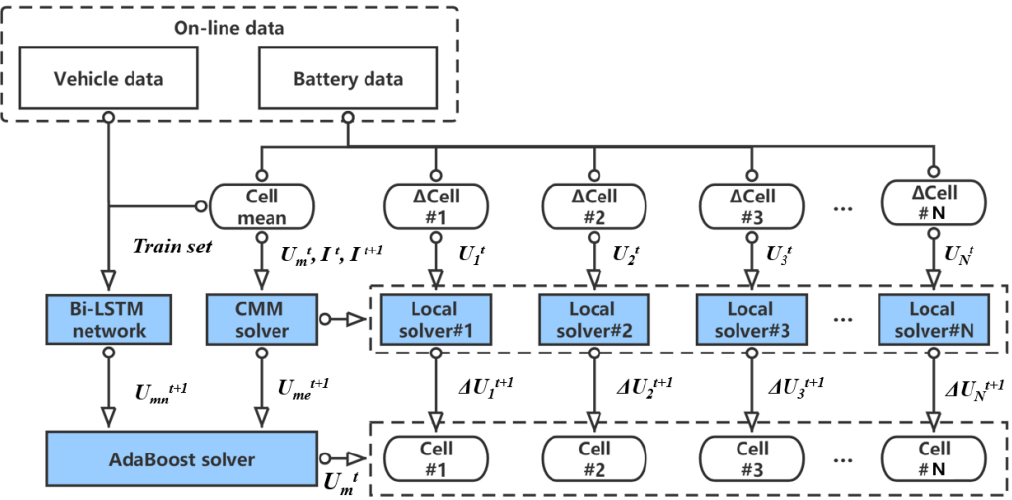
Figure 4. Schematic diagram of the adaptive prediction algorithm.